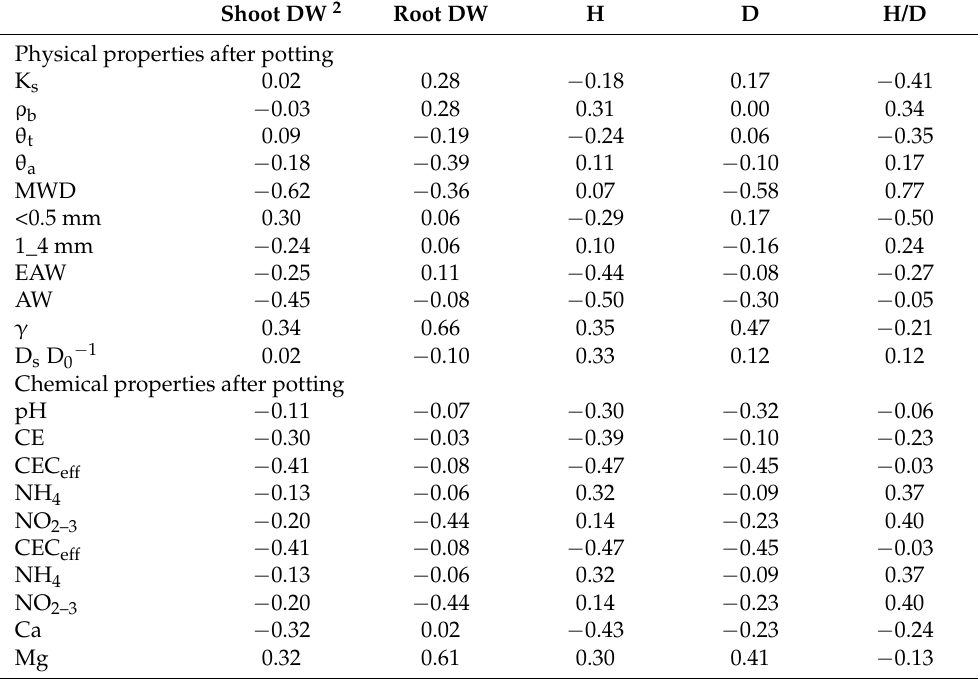
Table 4. Pearson correlation coefficients 1 between morphological variables and physical and chemical properties of forest nursery substrates after potting, quantities of nitrogen (N total ), phosphorous (P) and potassium (K) applied per seedling of white spruce (1+0) during the growing season and physical properties determined at the end of the growing